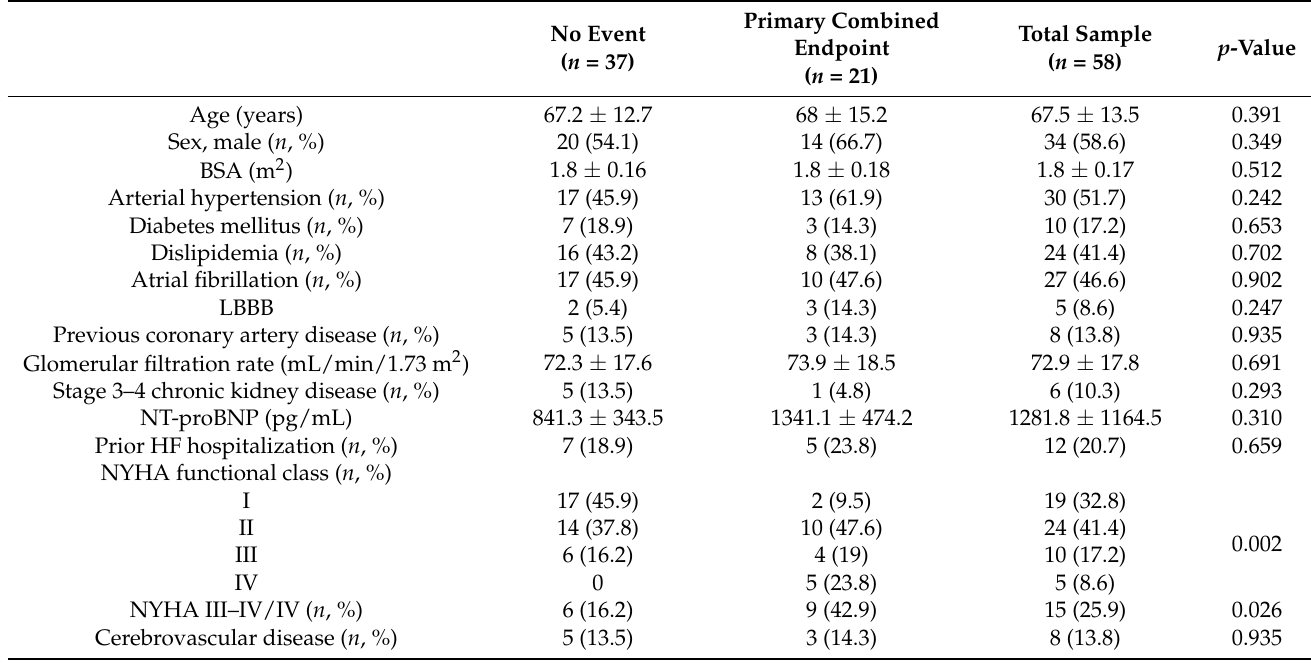
Table 1. Baseline clinical characteristics according to the primary combined endpoint.